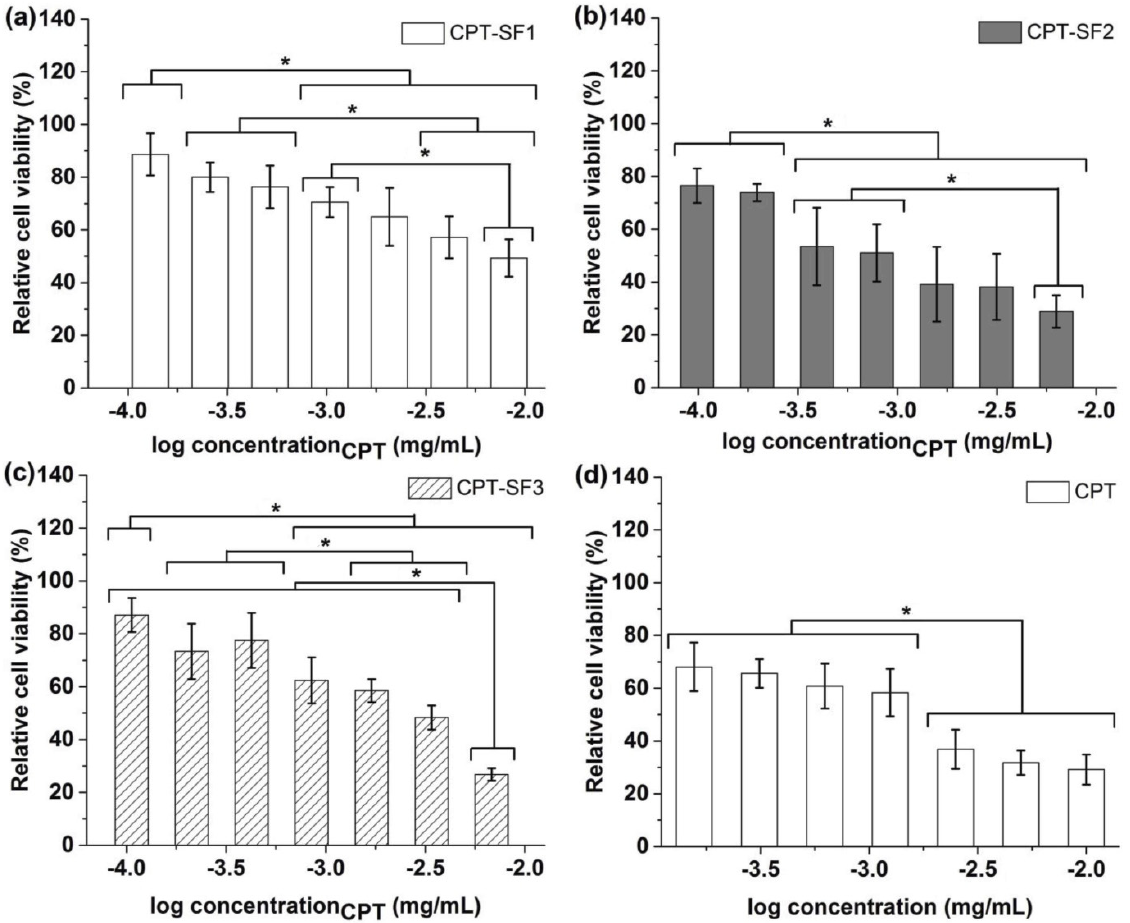
Figure 5. Relative viability of MCF-7 cells with ( a ) CPT-SF1 aggregates; ( b ) CPT-SF2 aggregates; ( c ) CPT-SF3 aggregates and ( d ) parent CPT (see structures in Figure 1). Mean ± standard deviation ( n = 3). * represent means with significant differences ( p < 0.05).